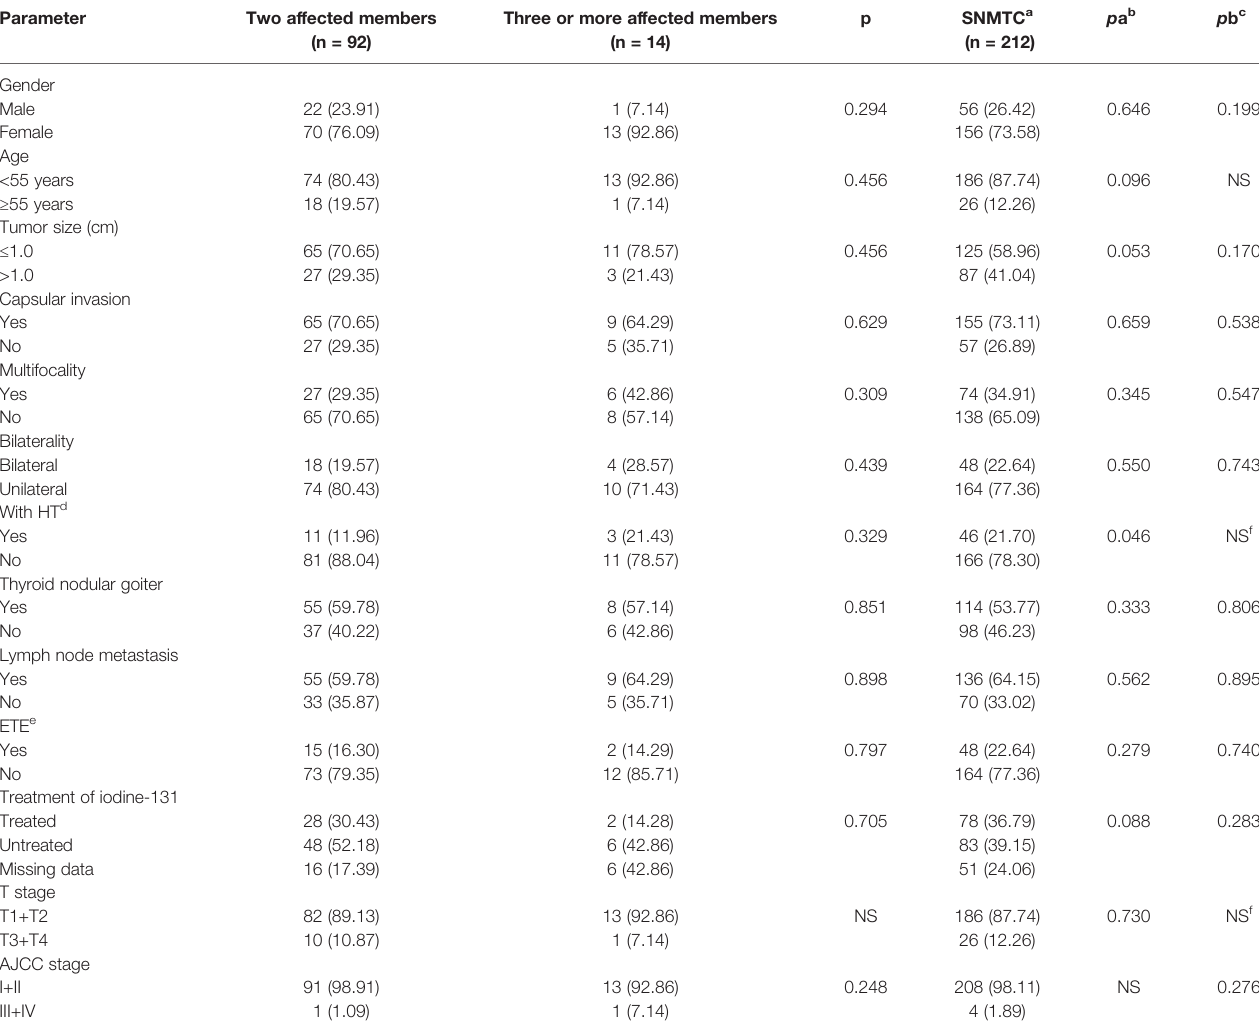
TABLE 3 | Clinicopathological characteristics and prognostic factors of two affected members group and three or more affected members group vs. SNMTC, n